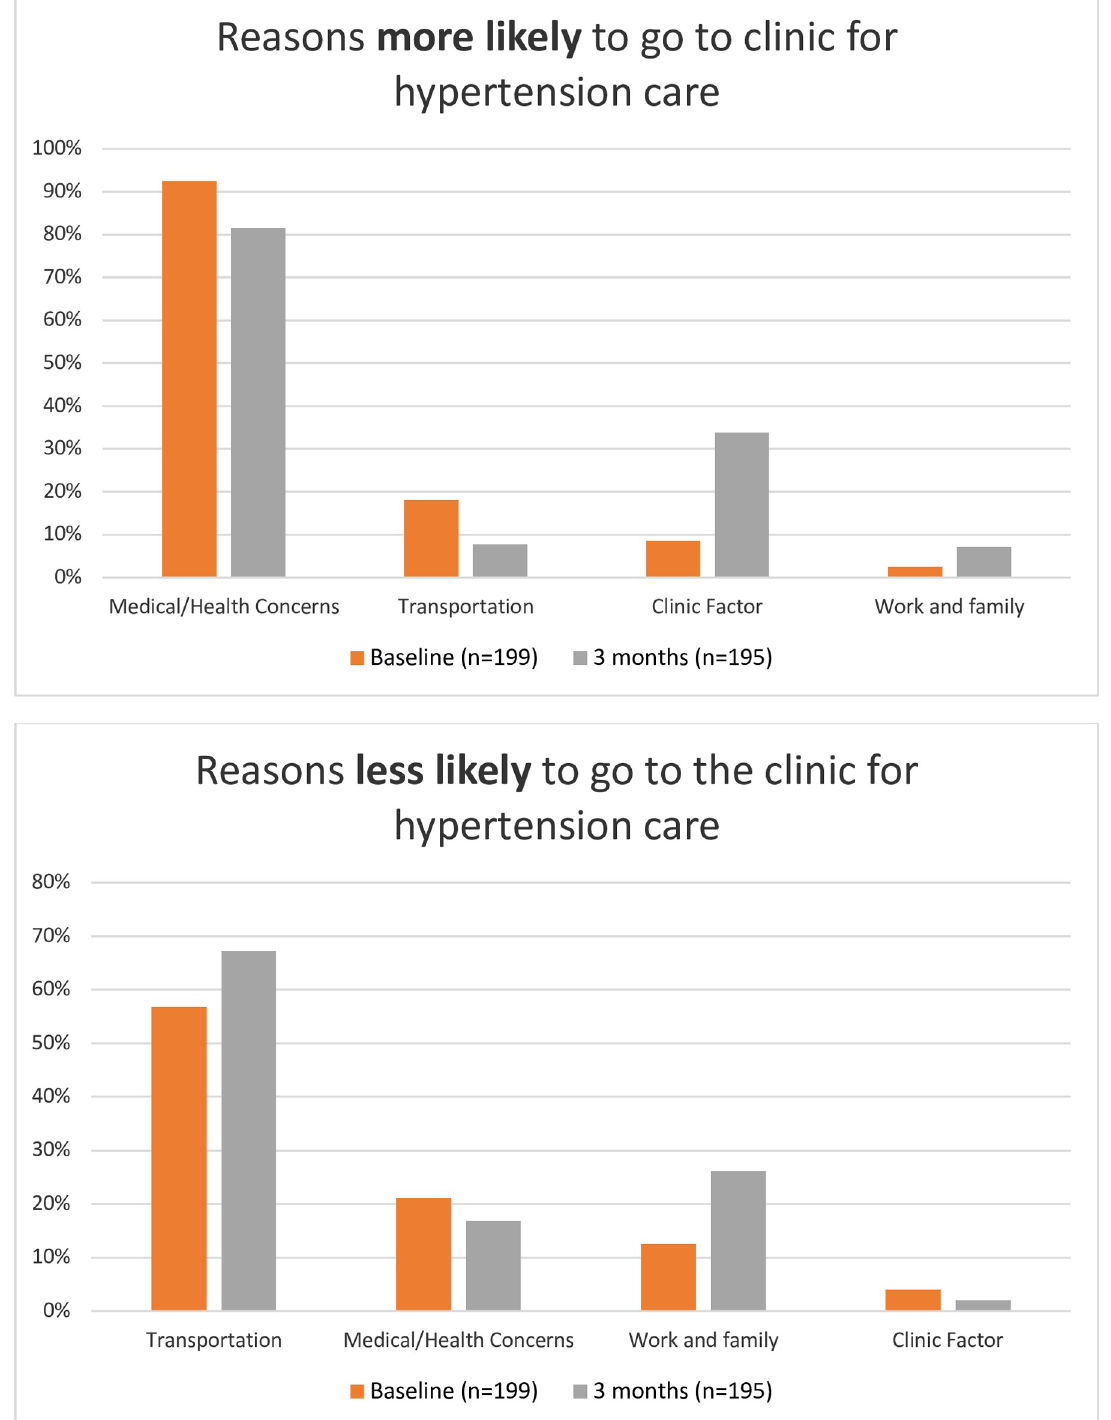
Fig 2. Self-reported barriers and facilitators of engagement in hypertension care.